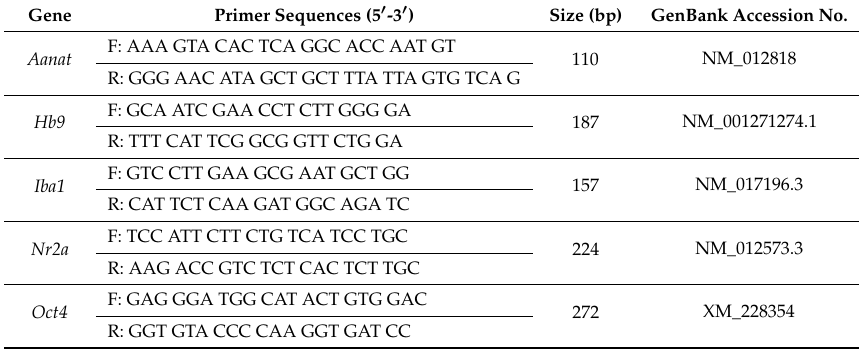
Table 1. Oligonucleotide primers used for